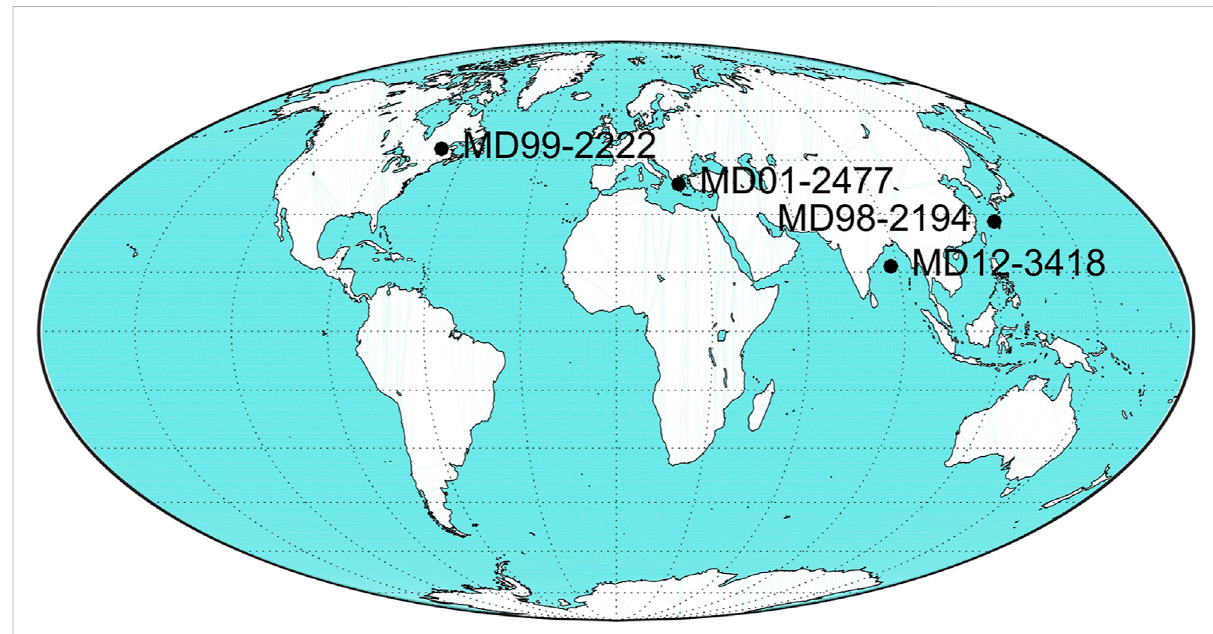
FIGURE 1 Location of the sampling sites of cores MD01-2477 (Gulf of Corinth), MD12-3418 (Bay of Bengal), MD98-2194 (China Sea) and MD99-2222 (Saguenay Fjord,